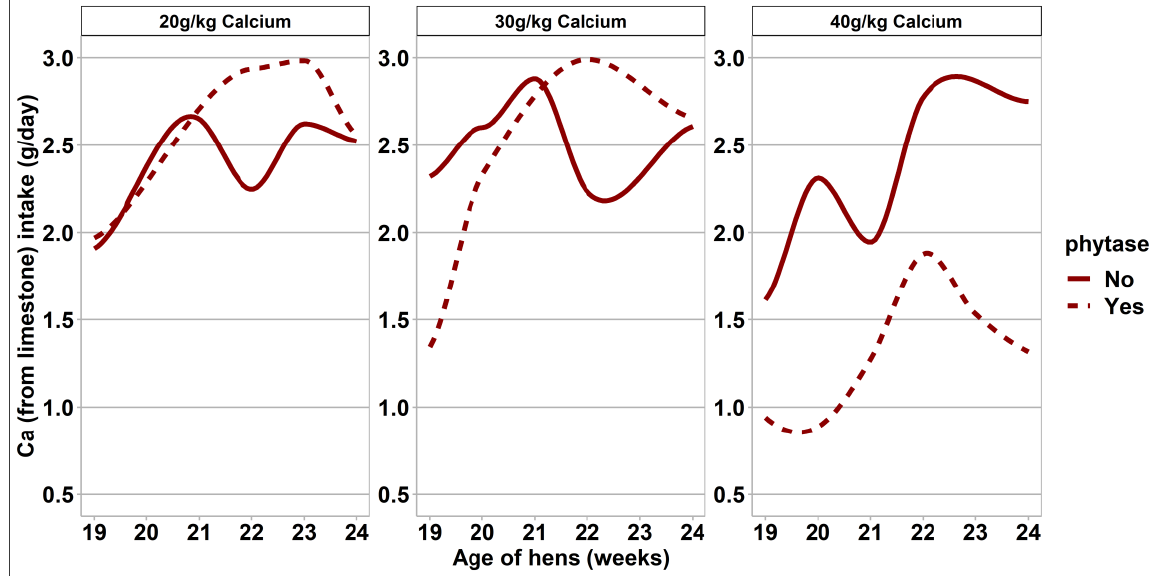
Figure 1. Trendlines of the estimated Ca intake from limestone (grams/hen/day) of hens offered a choice of limestone grit throughout the 6-week experimental period. The data were log-transformed prior to statistical analysis. The data presented here were back-transformed for meaningful visualization (n =